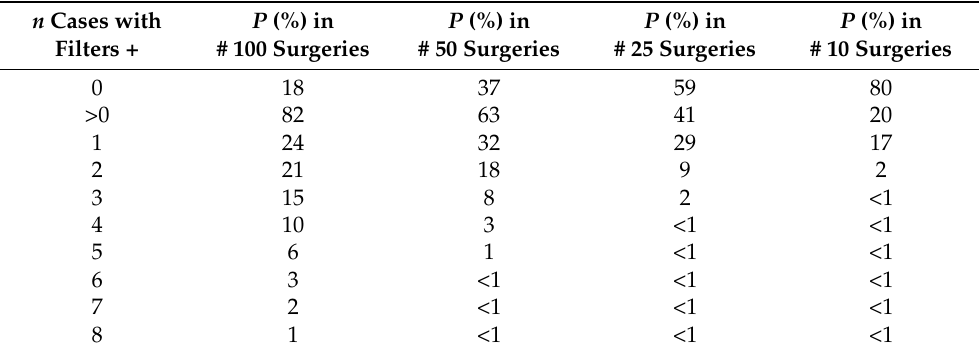
Table 3. Posterior predictive probabilities of positive filters corresponding to a distribution Beta- Binomial with parameters (#, 2,